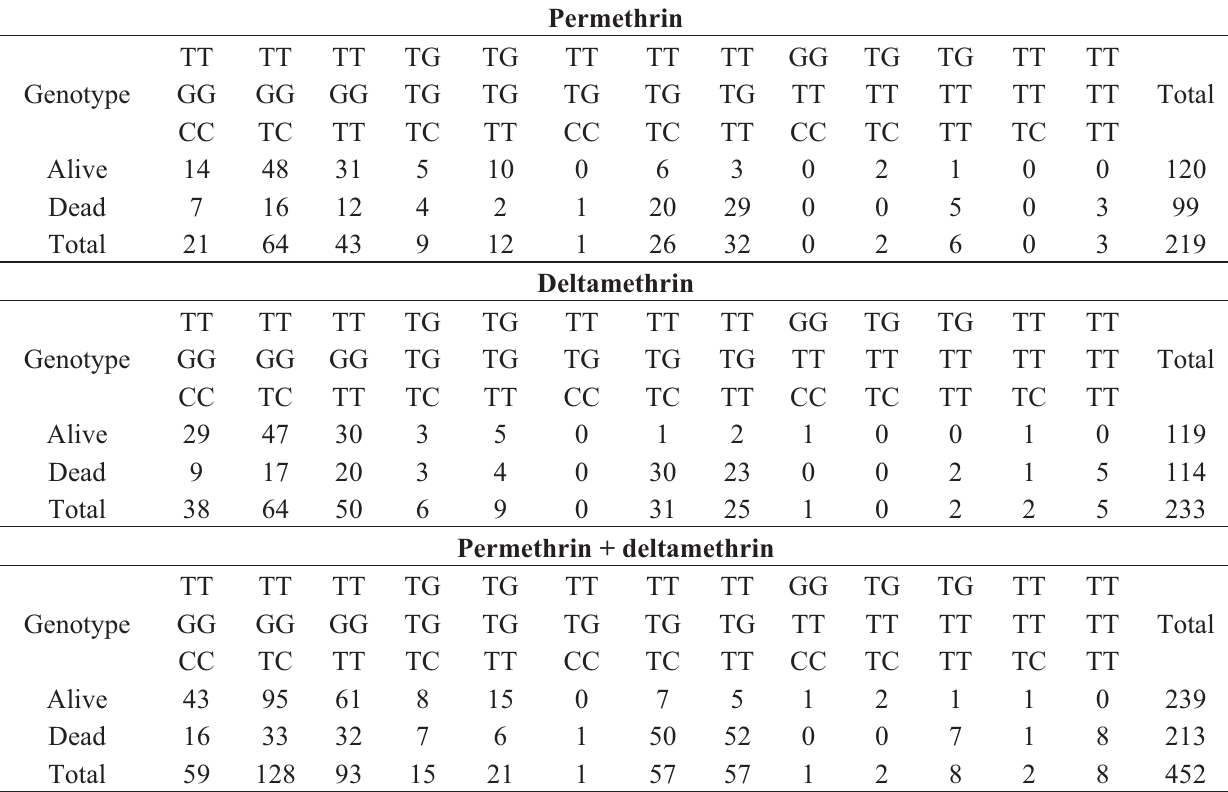
Table 10. Co-occurrence of Vssc mutations F1565C (T/G), V1023G (T/G) and S996P (T/C) in Aedes aegypti from Yogyakarta, Indonesia, Site 6, Site 8 and w MelYog line. Permethrin